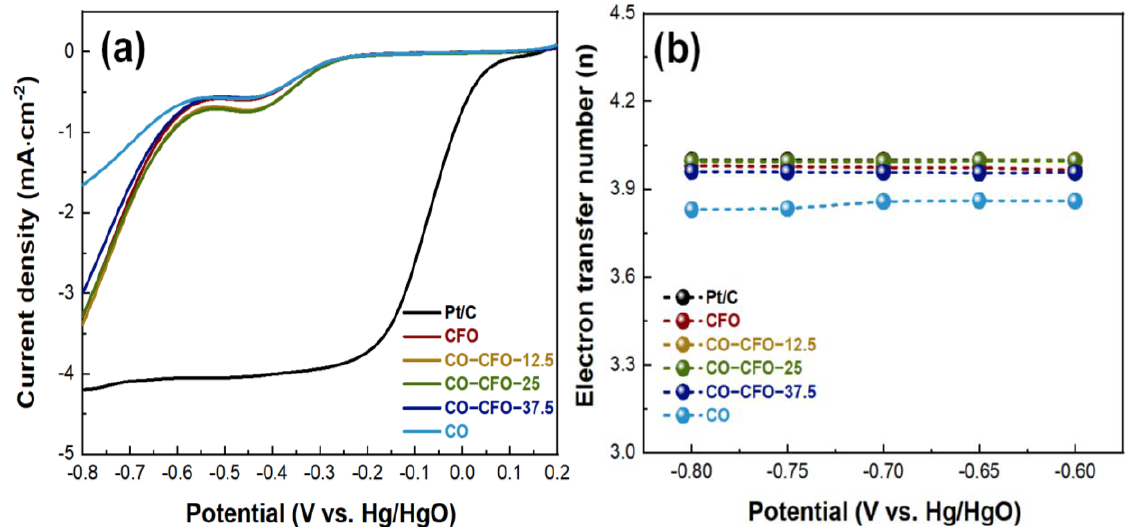
Figure 6. ( a ) Linear sweep voltammograms (LSV) for ORR curves and ( b ) Electron transfer number.